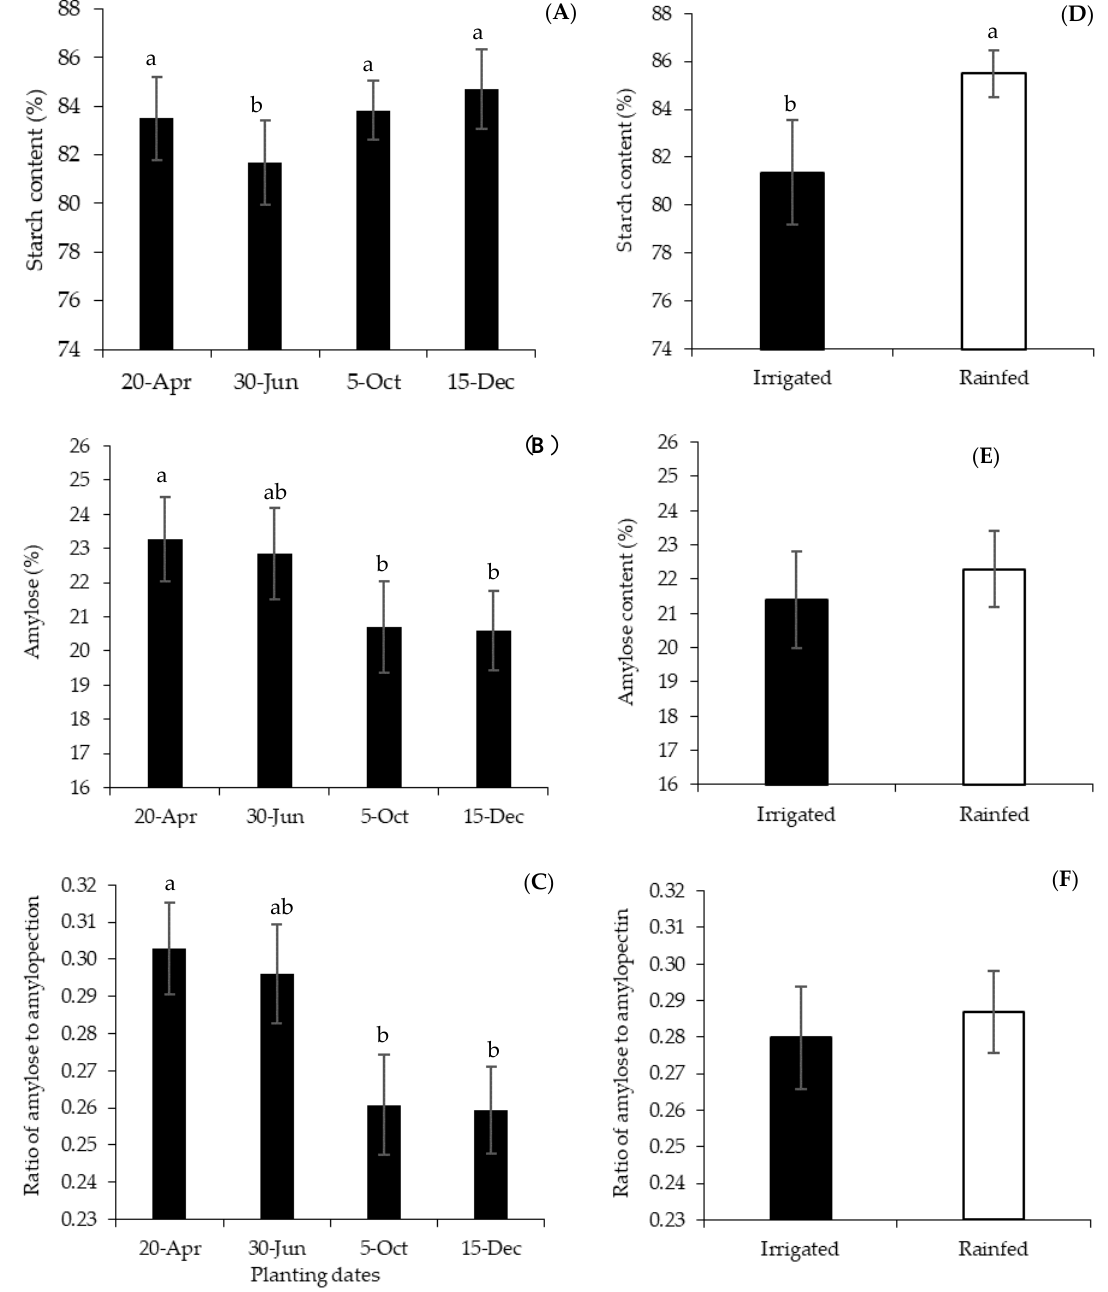
Figure 2. Means for starch content (%) ( A ), amylose content (%) ( B ) and ratio of amylose to amylopectin ( C ) of cassava cv. Rayong 9 for both irrigated and rainfed conditions at harvest (12 months after planting (MAP)) and comparison of means between irrigated and rainfed conditions for those traits ( D – F ). The di ff erent letters are significantly di ff erent by Duncan’s multiple range test (DMRT) ( p < 0.05). Mean between irrigation and rainfed treatments was tested statistically by least significant di ff erence (LSD). The Vertical bar indicates standard deviation .